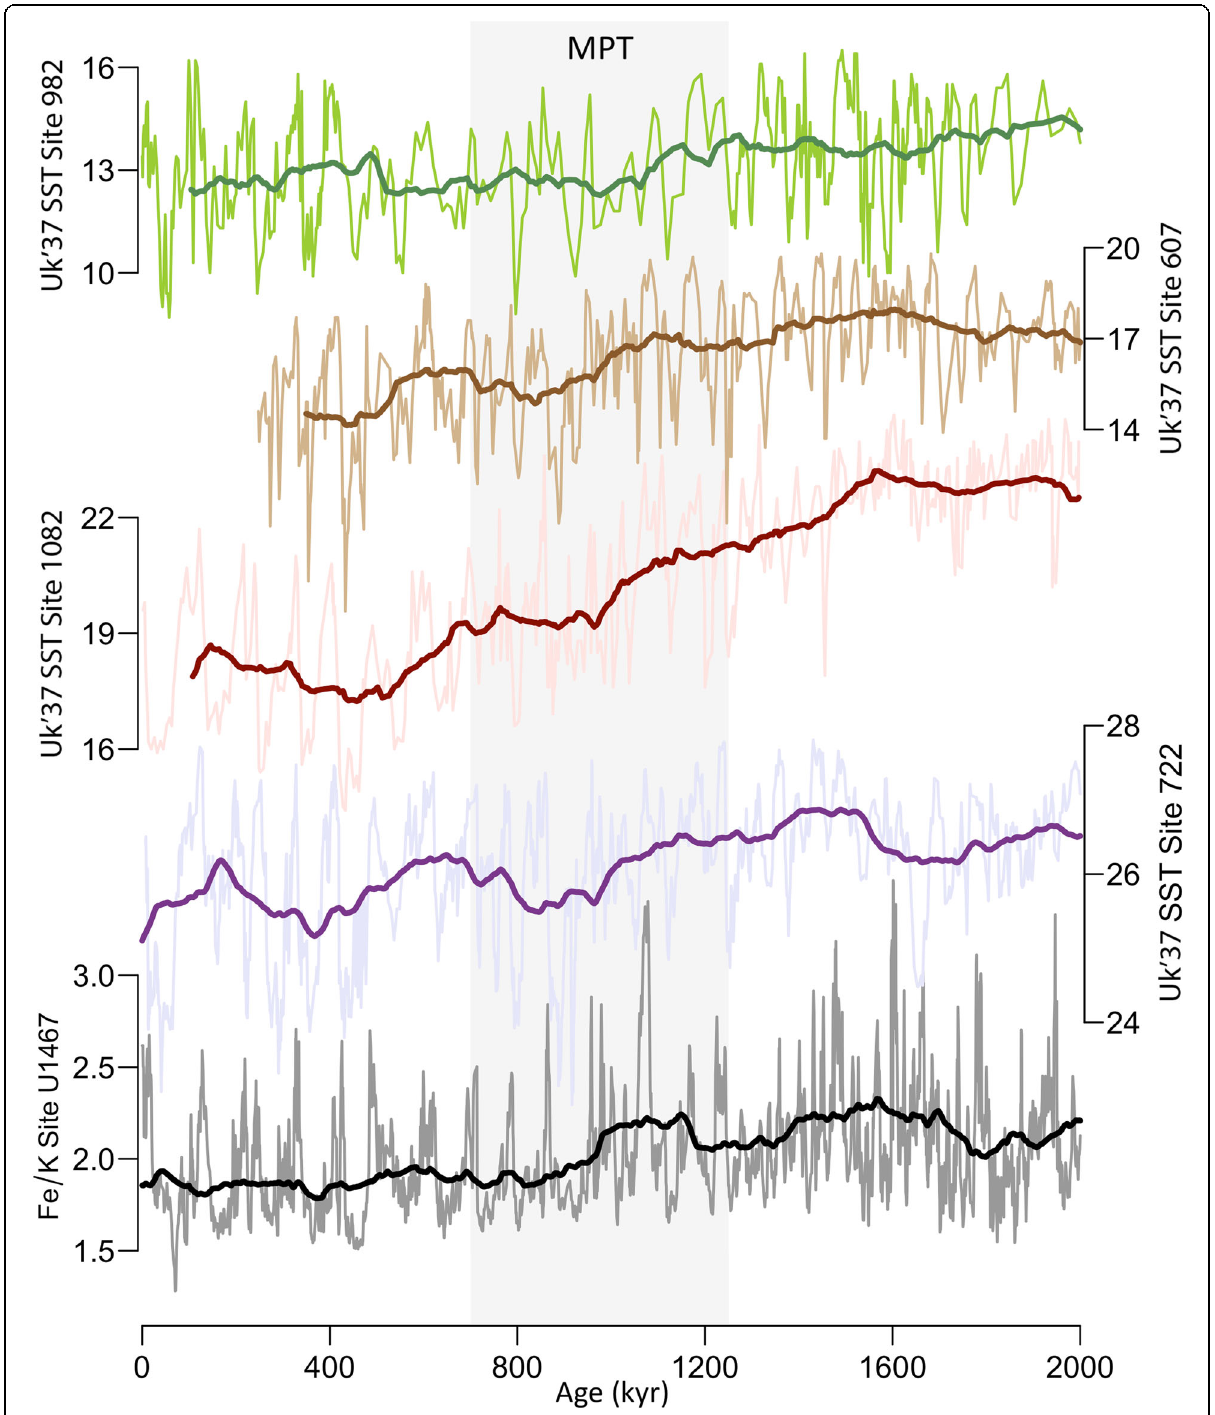
Fig. 14 Temperature records based on alkenones from various boreholes in the Atlantic and Arabian Sea. Sites 607 and 982 were drilled in the N-Atlantic; Site 1082 was drilled in the South Atlantic and Site 722 in the western Arabian Sea. A 200 kyr moving average smoothing was applied (bold line) to reveal the long-term trends. The early onset of a fall in temperatures in Sites 607 and 722 coincides with the early drop in Fe/K ratios in Site U1467 prior to the switch in dominance of the 41 kyr to the 100 kyr around 1.25 Ma. There is a strong resemblance of the long-term trends in the Fe/K record with the temperature